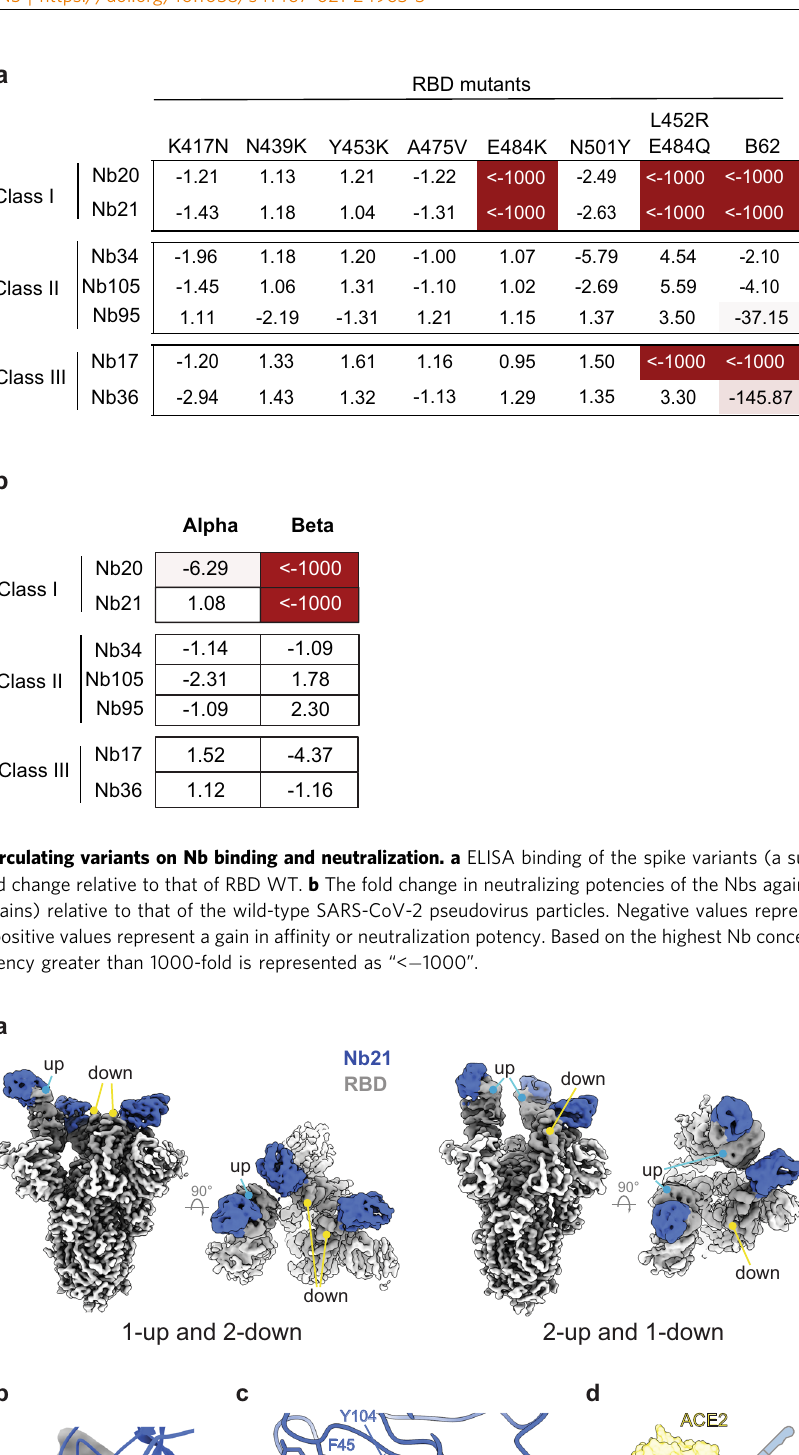
NATURE COMMUNICATIONS| (2021) 12:4676